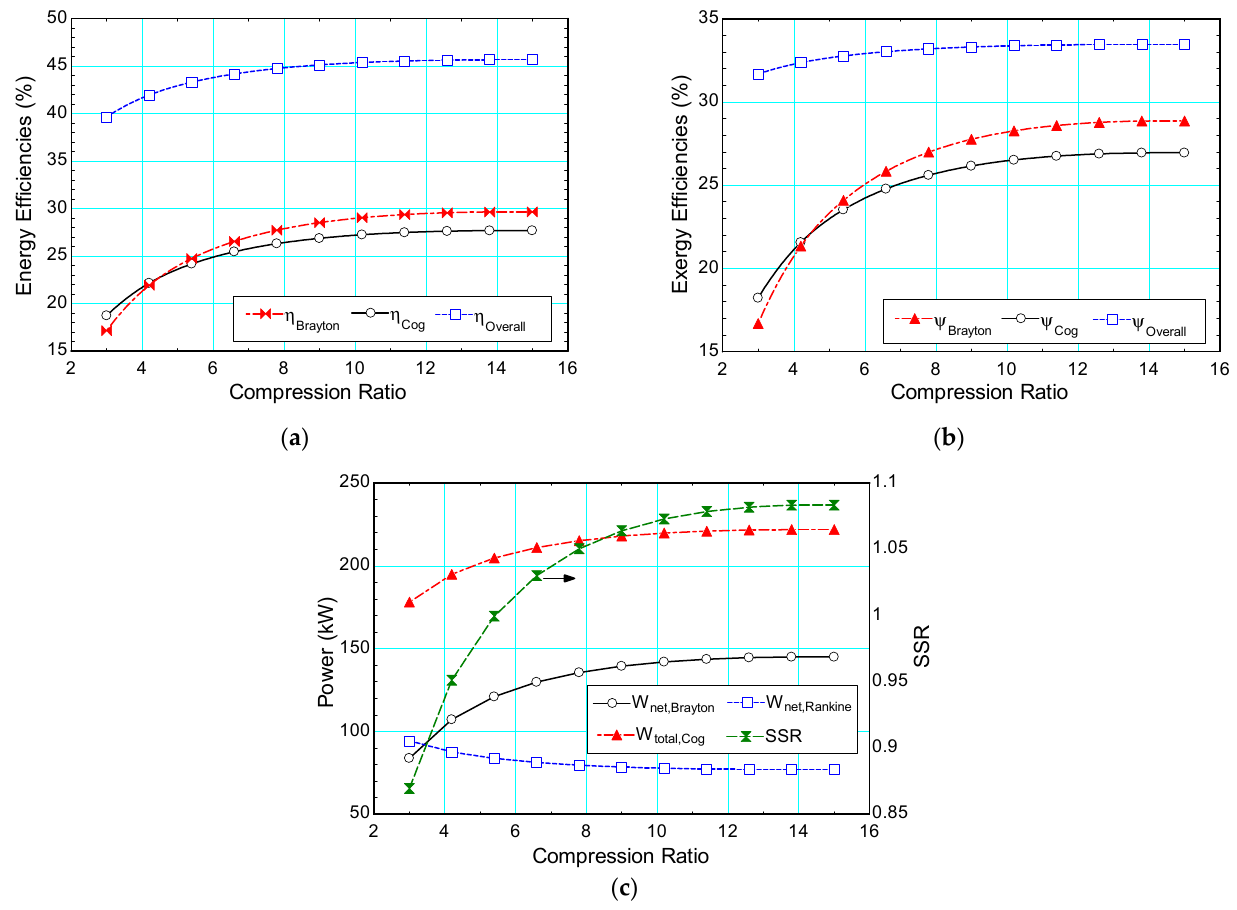
Figure 8. Compression ratio effect on: ( a ) energy efficiencies, ( b ) exergy efficiencies, ( c ) power production, and self-sufficiency ratio (total required power for the WWTP is 184.3 kW).